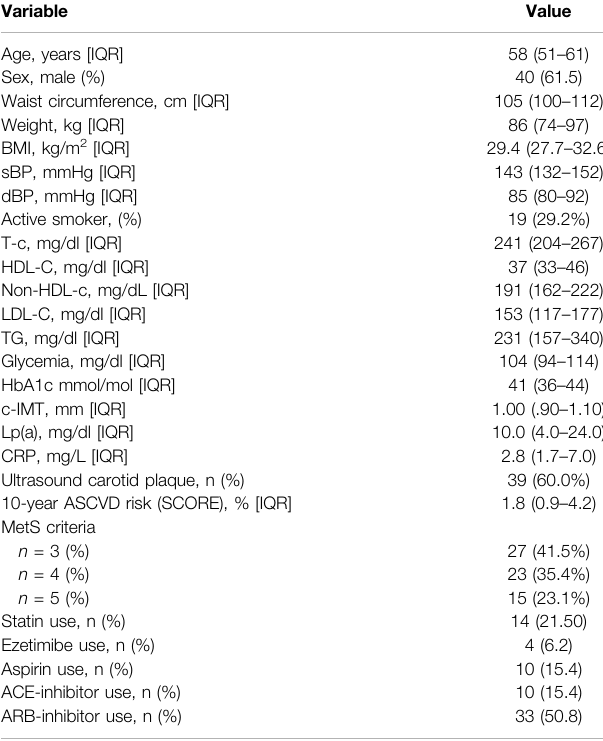
TABLE 1 | Characteristics of sixty fi ve patients with metabolic